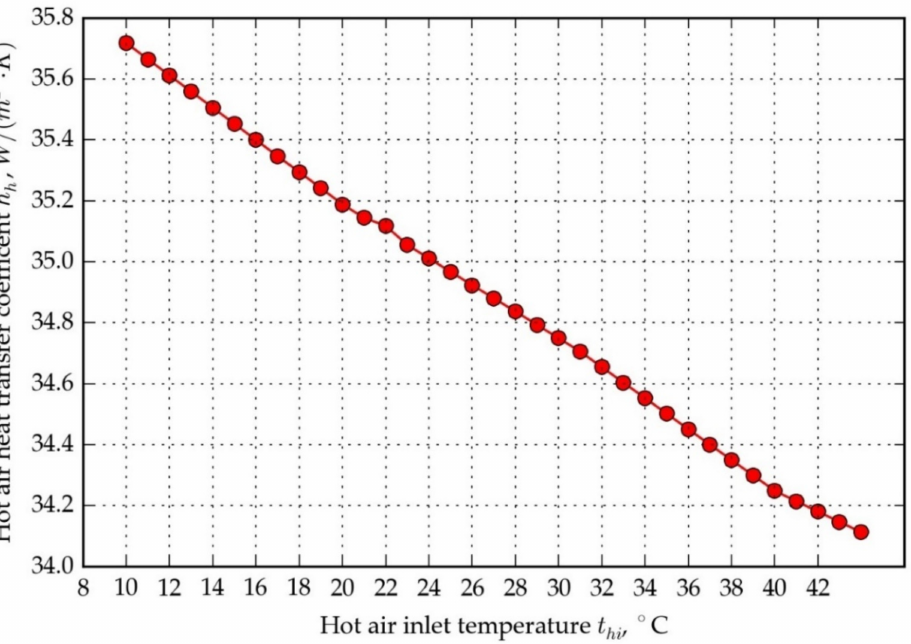
Figure 15. Hot air heat transfer coefficient vs. hot air inlet temperature, for cold air inlet temperature 0 ◦